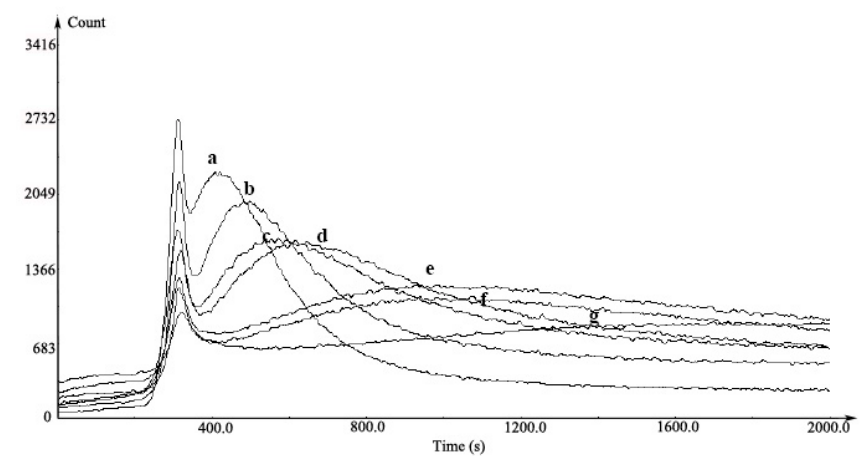
Figure 6. The inhibition of EPS from Bacillus cereus SZ1 on chemiluminescence induced by DNA damage. a, reaction mixture (copper sulfate, 0.05 mM; 1,10-phenanthroline, 0.35 mM; ascobate acid; 0.35 mM in pH 5.2 NaOAc/HOAc buffer (0.1 M) and 0.5% H 2 O 2 ) with 1 μ g/mL DNA; b–g, reaction mixture containing 1 μ g/mL DNA with the EPS at 0.167, 0.333, 0.667, 1.000, 1.333 and 1.667 mg/mL, respectively.